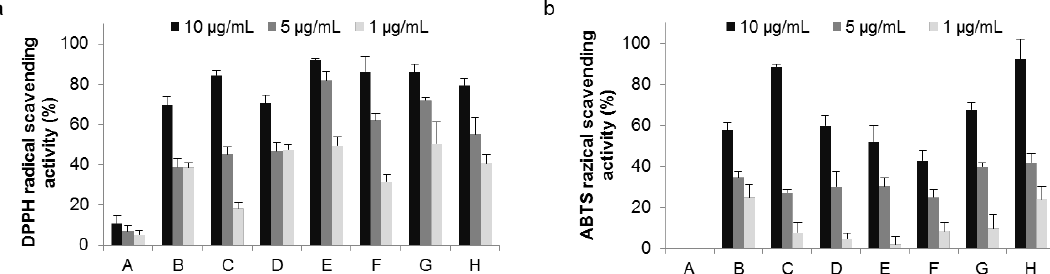
Figure 3. Radical scavenging activity in raspberry leaf extracts. ( a ) DPPH radical scavenging